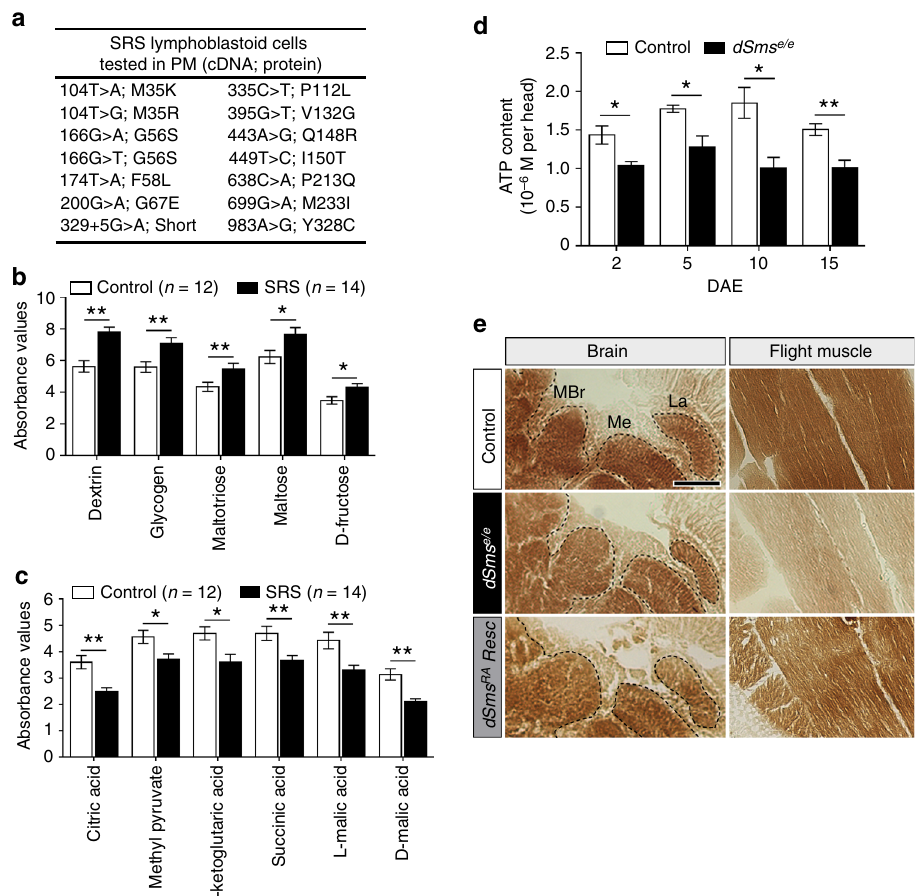
Fig. 6 Mitochondria function is impaired in SRS cells and dSms mutant fl ies. a List of pathogenic SMS variants identi fi ed so far in SRS patients and tested in phenotype microarray. b , c Phenotype microarray pro fi le (mean ± S.E.M.) showing the utilization of sugars ( b ) and compounds metabolized in the Krebs cycle ( c ) in lymphoblastoid cells from control ( n = 12) and SRS patients ( n = 14, indicated in a ). d ATP content measured using bioluminescence assay from fl y heads extracted at different ages (mean ± S.E.M.; n = 5 biological replicates, 10 heads each). e Histochemical analysis of COX activity in brain and fl ight muscle. Black dashed outline delineates different brain regions. MBr, middle brain; Me, medulla; La, lamina. Scale bar, 100 µ m. Note decreased color intensity in the mutant group. b – d Student ’ s t test; * P < 0.05, ** P <